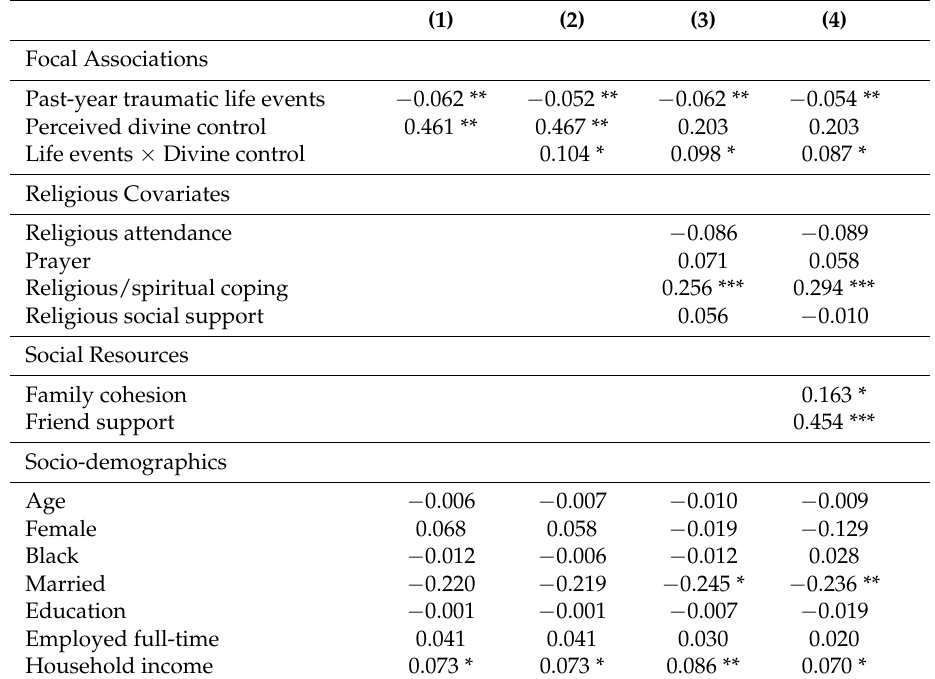
Table 2. Logit coefficients from ordered logistic regression models estimating increased positive reappraisals ( n =